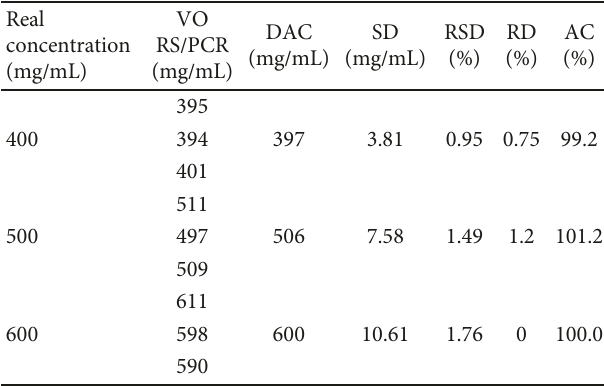
Table 3: Solutions of di ff erent concentrations in triplicate (400, 500, and 600mg/mL) used to calculate the precision (RSD) and accuracy (AC).